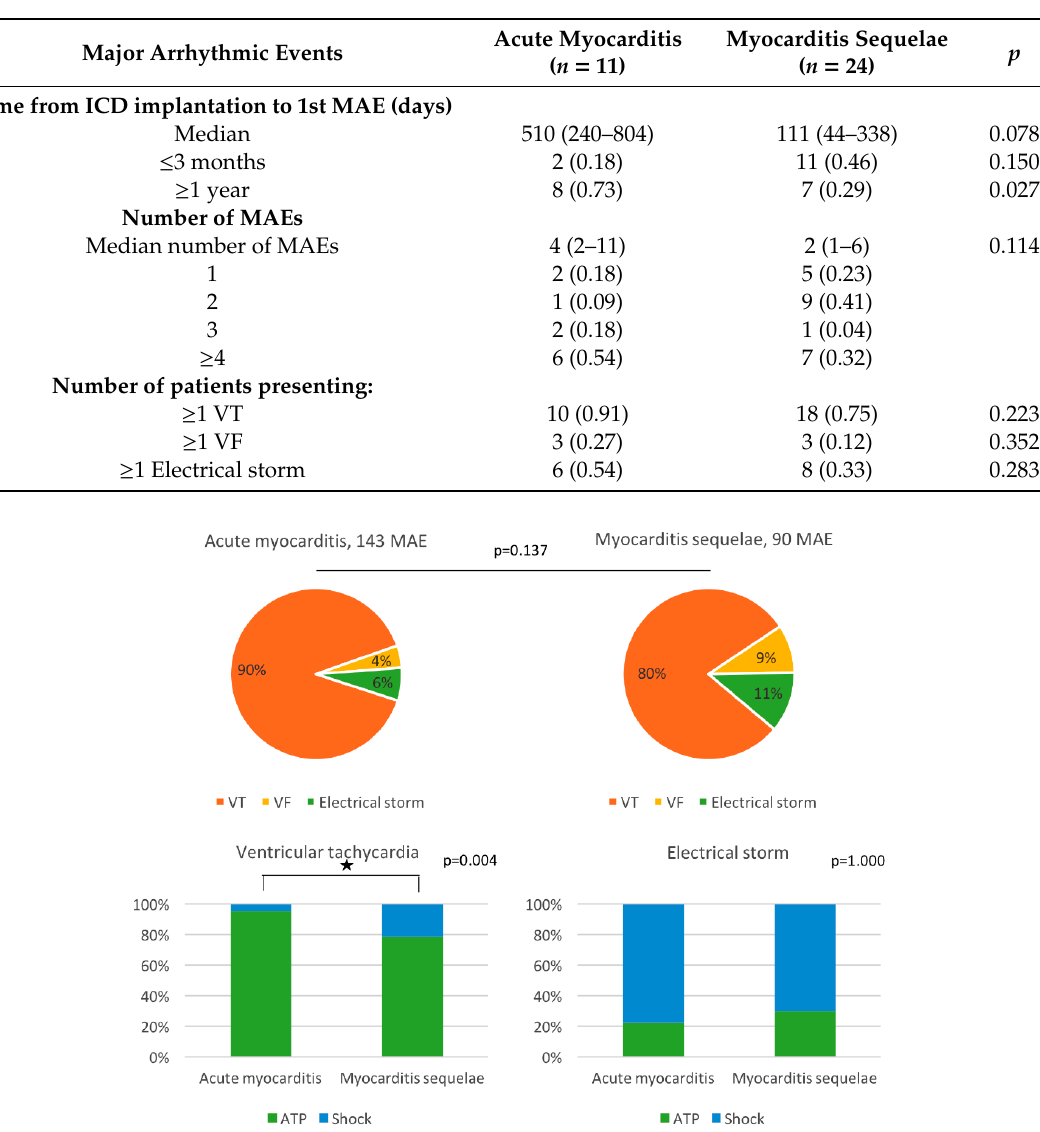
Table 7. Univariate and multivariate backward stepwise Cox regression analysis to estimate predictors of major arrhythmic ventricular events in the total ICD population ( n = 61 after exclusion of 7 missing data patients).